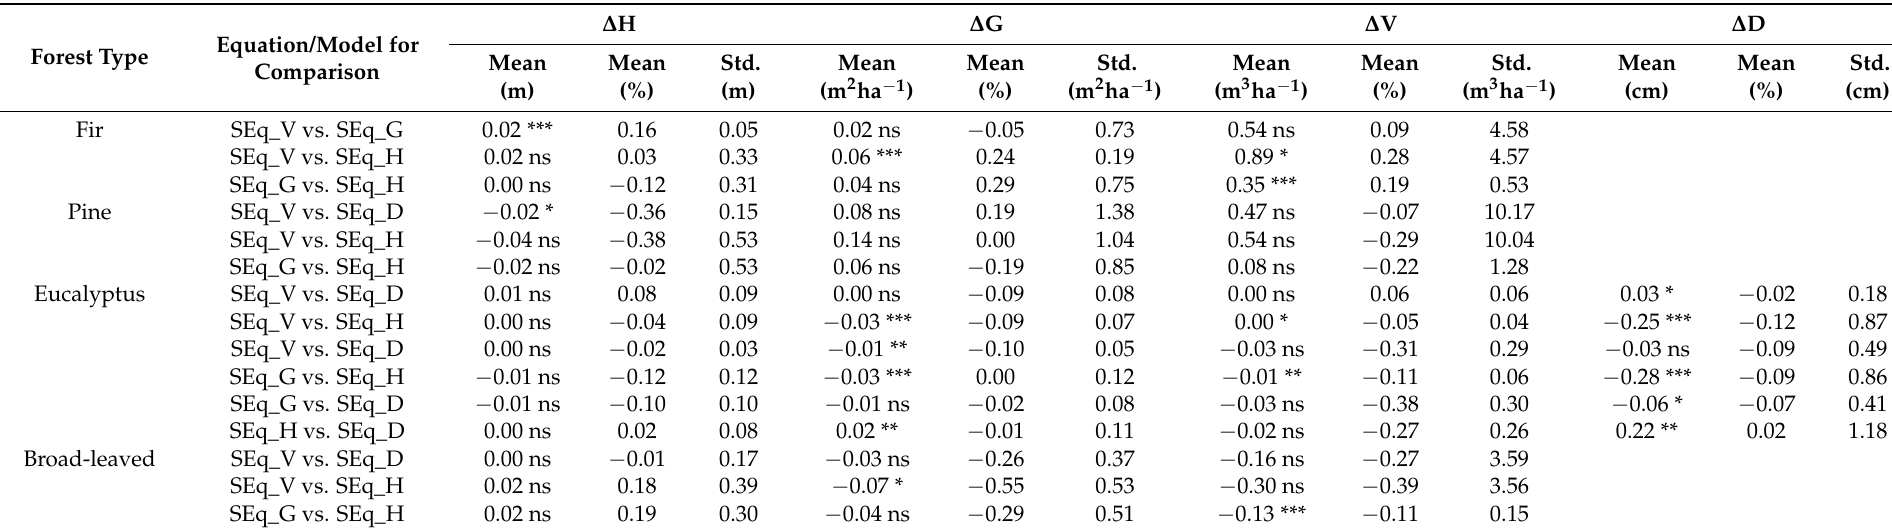
Table 4. Results of paired t -test of the mean stand attribute estimates for various forest types between the simultaneous